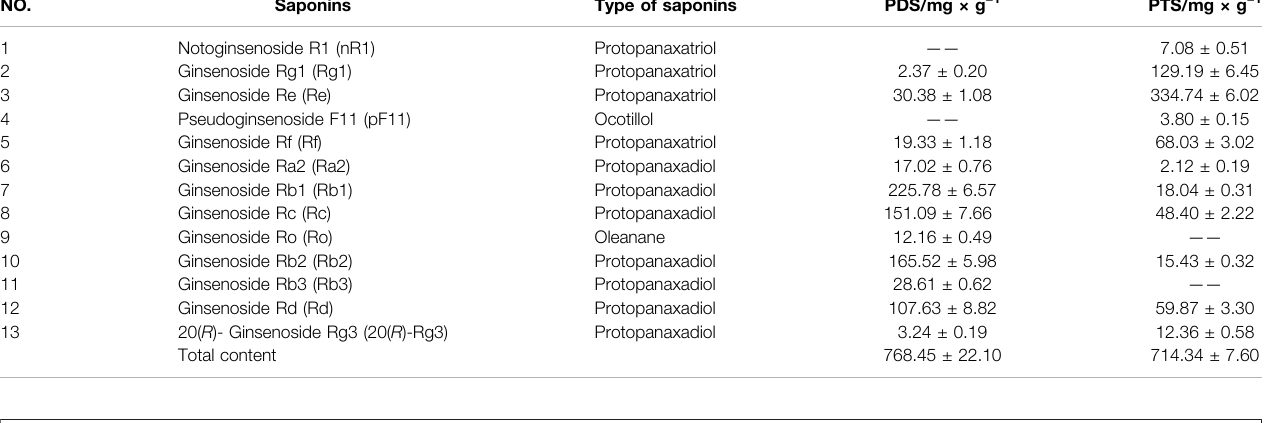
TABLE 1 | Ginsenoside Content of PDS and PTS as Determined by UHPLC ( ‾ x ± SD, n = 3). NO.